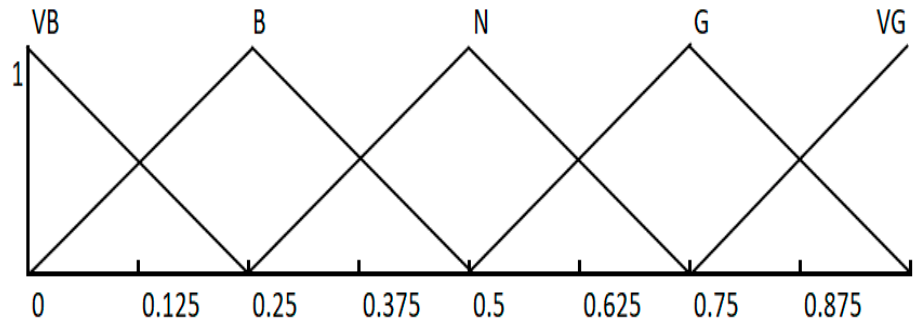
Figure 2. A set of five linguistic terms and their semantics.